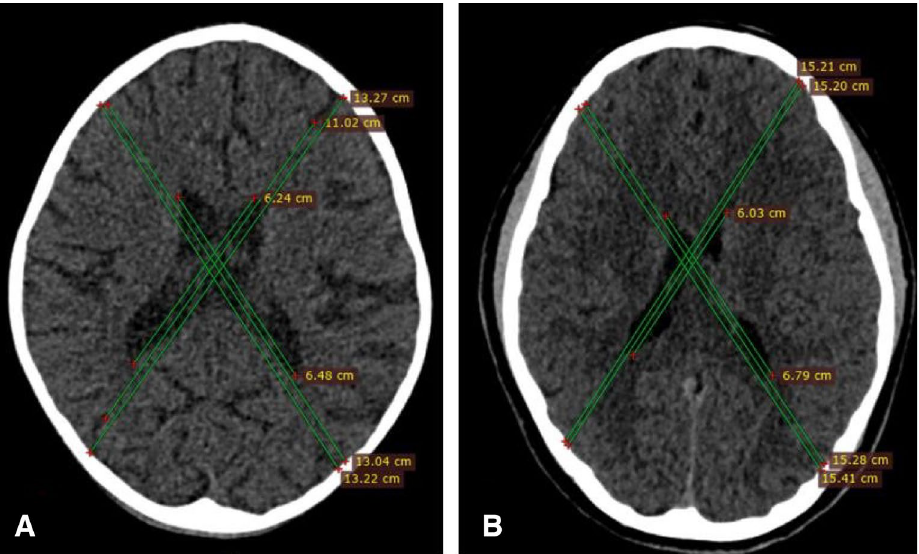
Figure 1. Brain CT scan sections at the widest part of the lateral ventricular body. ( A ) A case of brain atrophy from a 6-year-old male child showing prominent sulci and enlarged lateral ventricular body with a DBF value of 0.58 consistent with grade-II brain atrophy. ( B ) A normal brain volume of a 13-year-old male child showing effaced sulci intimately related to the calvarium, normal size lateral ventricular body with a DBF value of